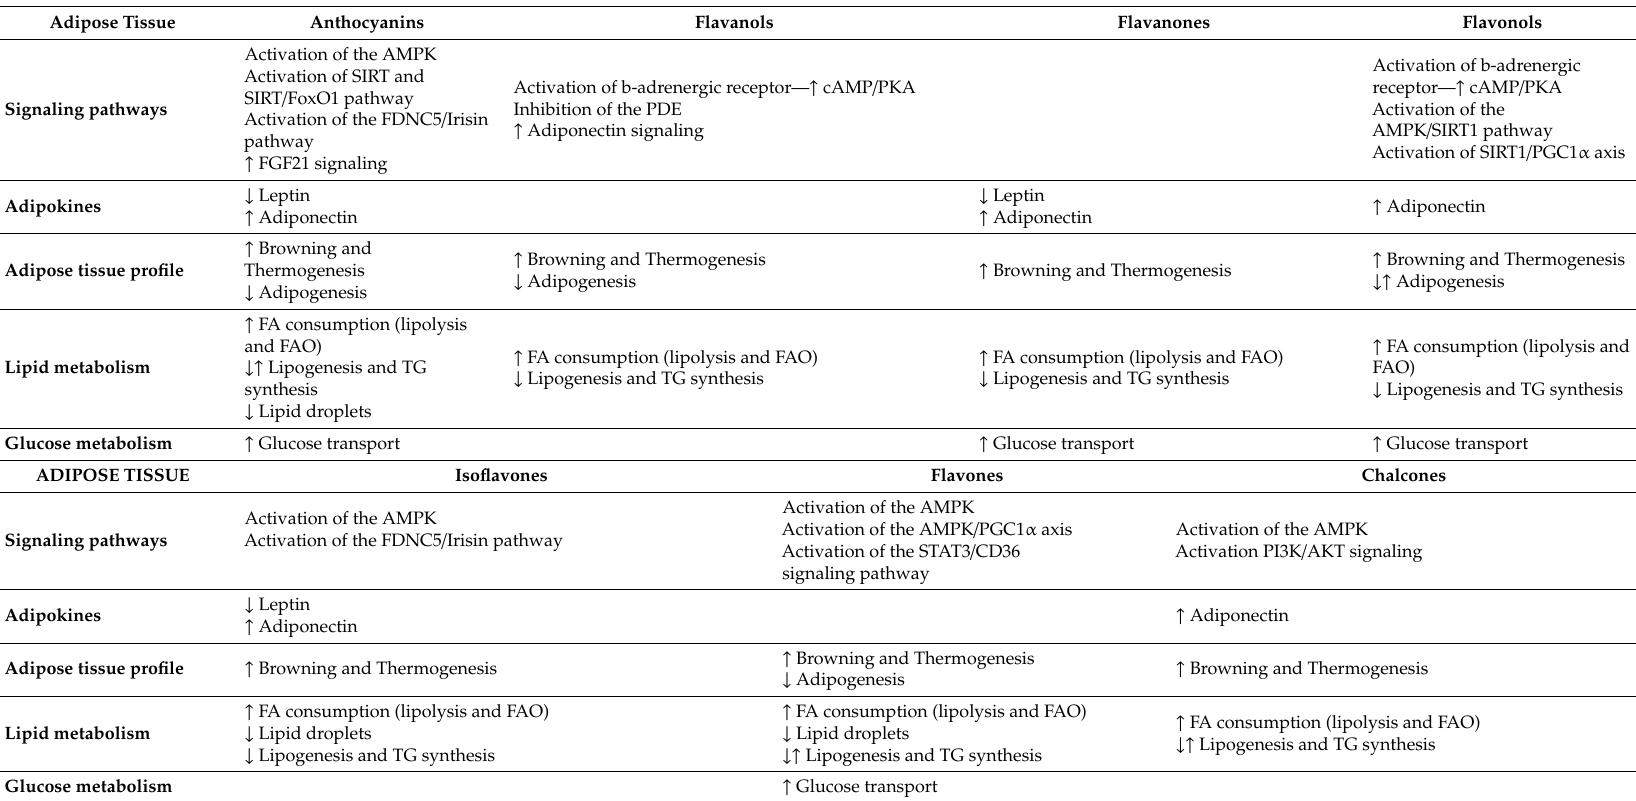
Table 3. Metabolic e ff ects and signaling pathways underlying the anti-obesity e ff ects of flavonoids in the adipose tissues. Adipose